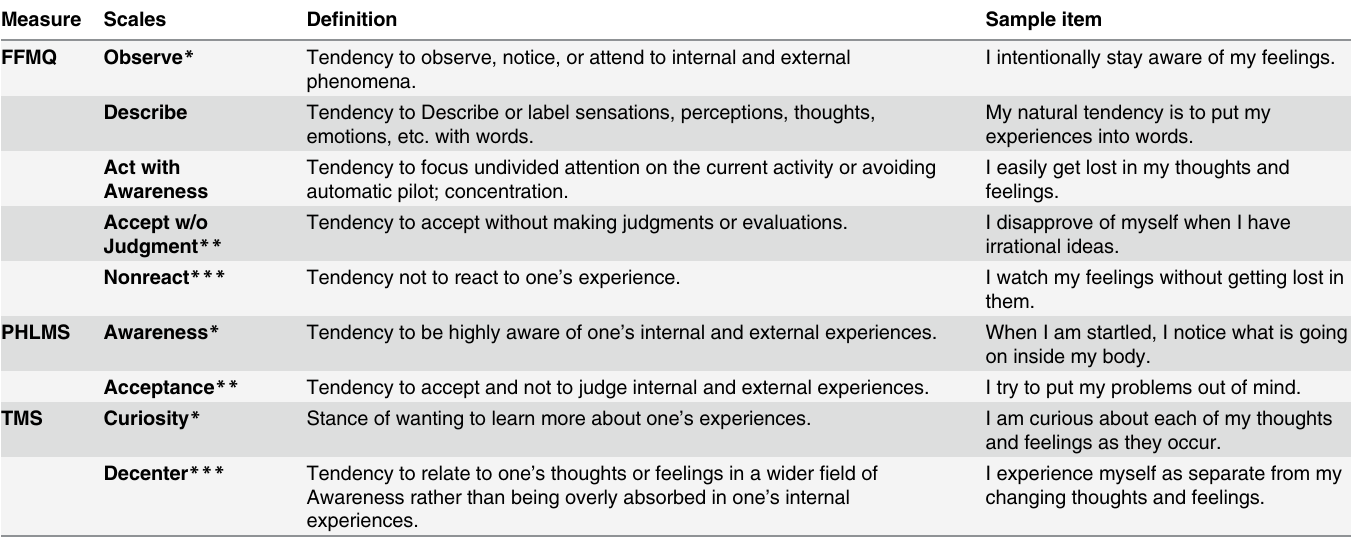
Table 1. Operationalisation of Mindfulness across Multi-Faceted Measures, Including Facet or Subscale Definitions and Sample Items. Measure